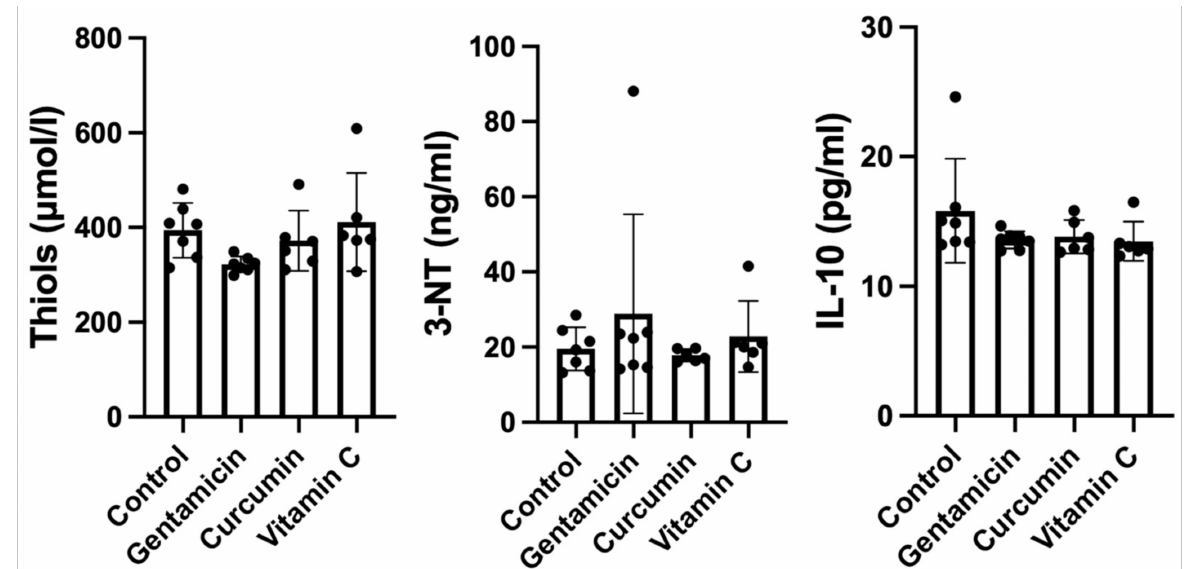
Figure 3. Box-plot showing serum levels of thiols, 3-nitrotyrosine and interleukin-10 in our study groups ( p > 0.05).